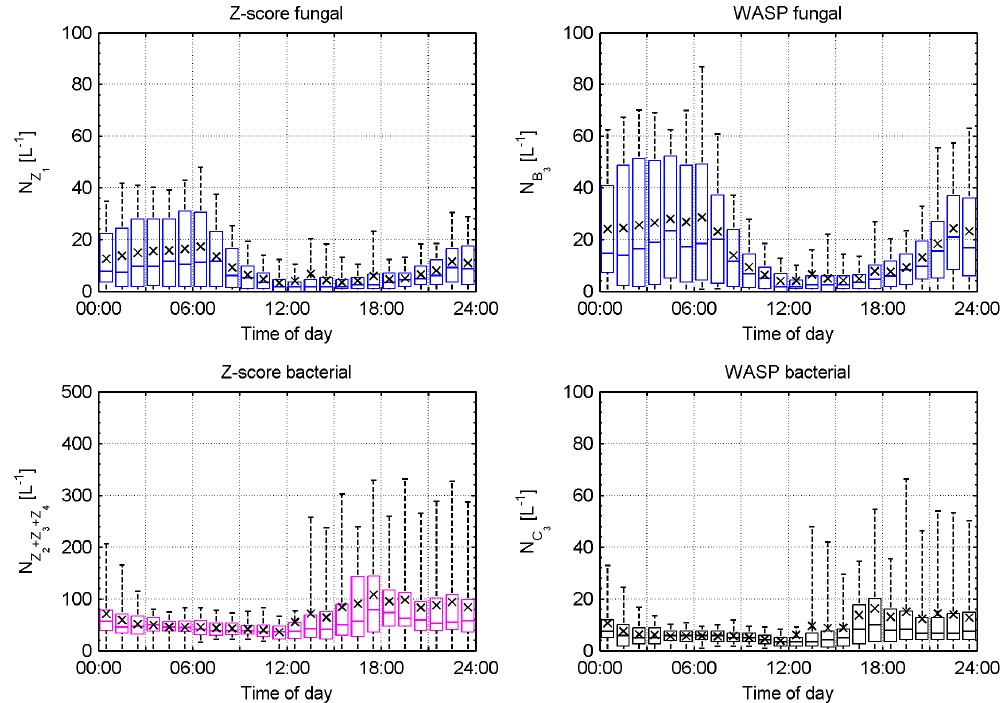
Figure 9. Top panels: hourly average diurnal cycle of fungal cluster concentration for z -score normalisation (left panels) and WASP (right panels) over the period 27 July 2011–7 August 2011. Bottom panels: same as for top panels but for the bacterial clusters. Whiskers denote 5th and 95th percentiles. Mean value indicated by x marker. Note change in scale for bacterial